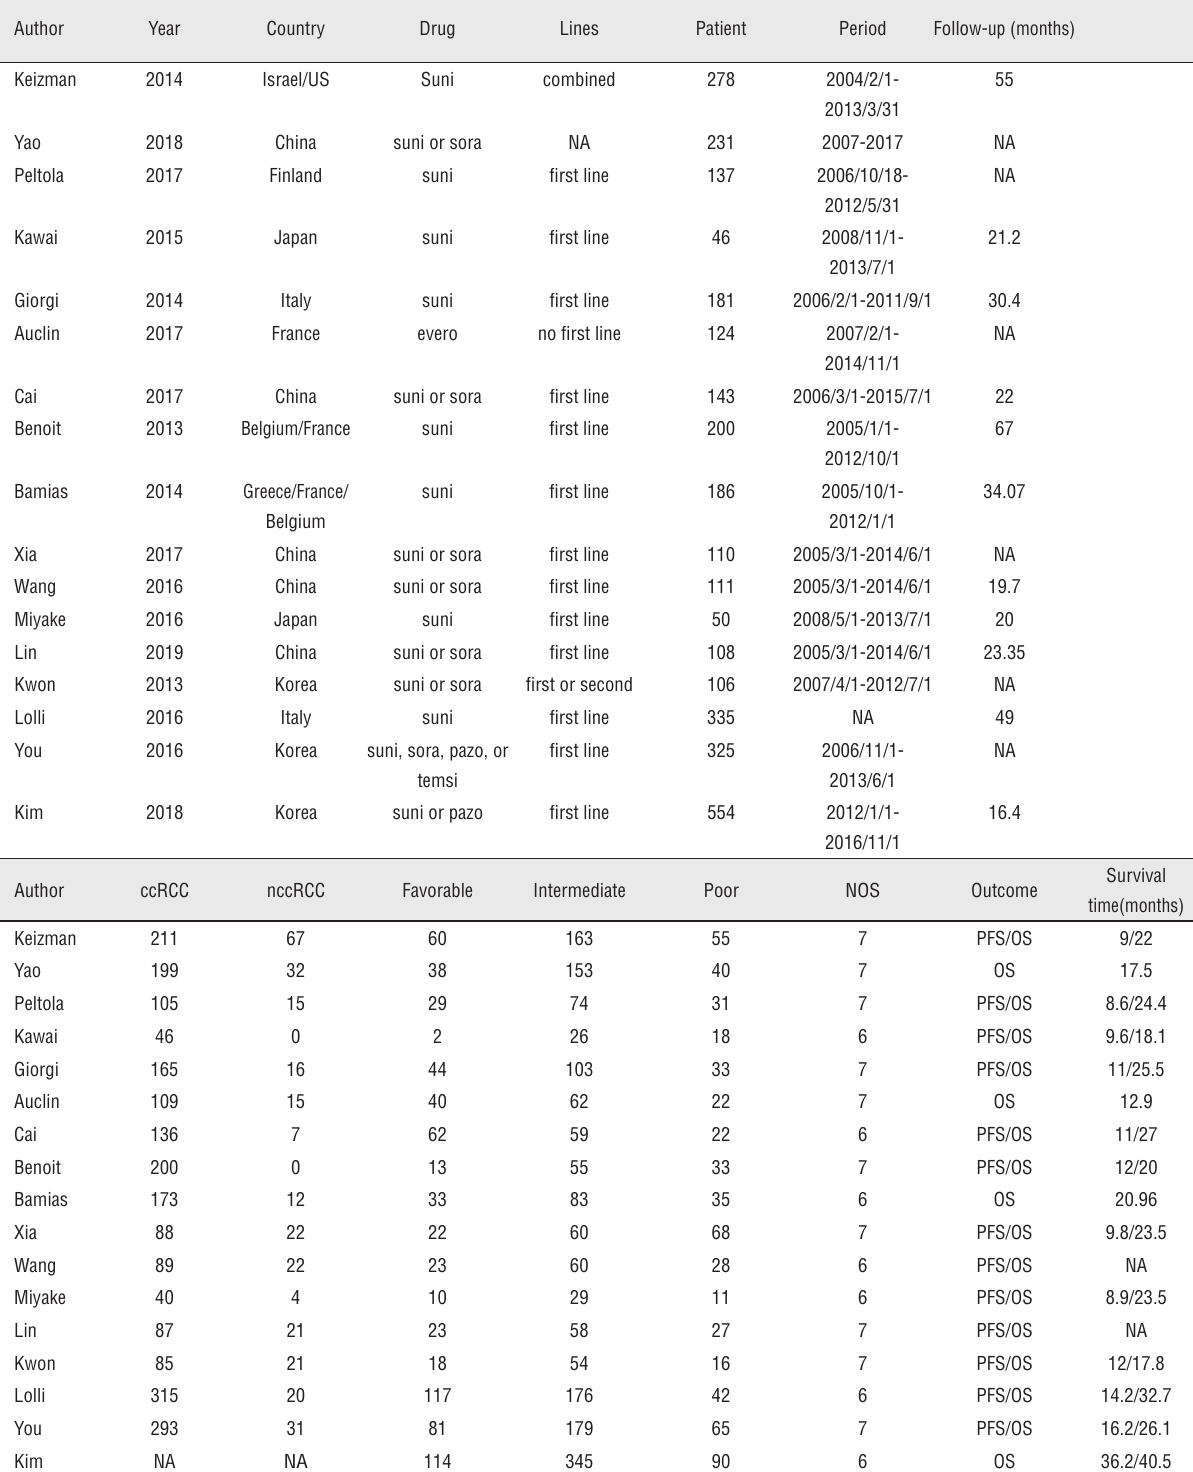
Table 1- The summary characteristics of 17 included